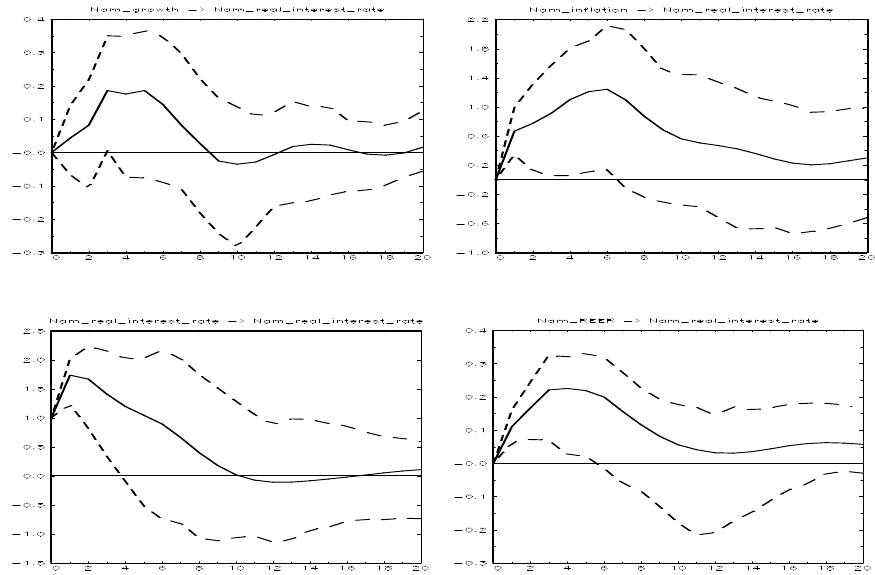
FIGURE 4: Impulse-response functions for Namibia (real interest rate responding) Source: Authors'